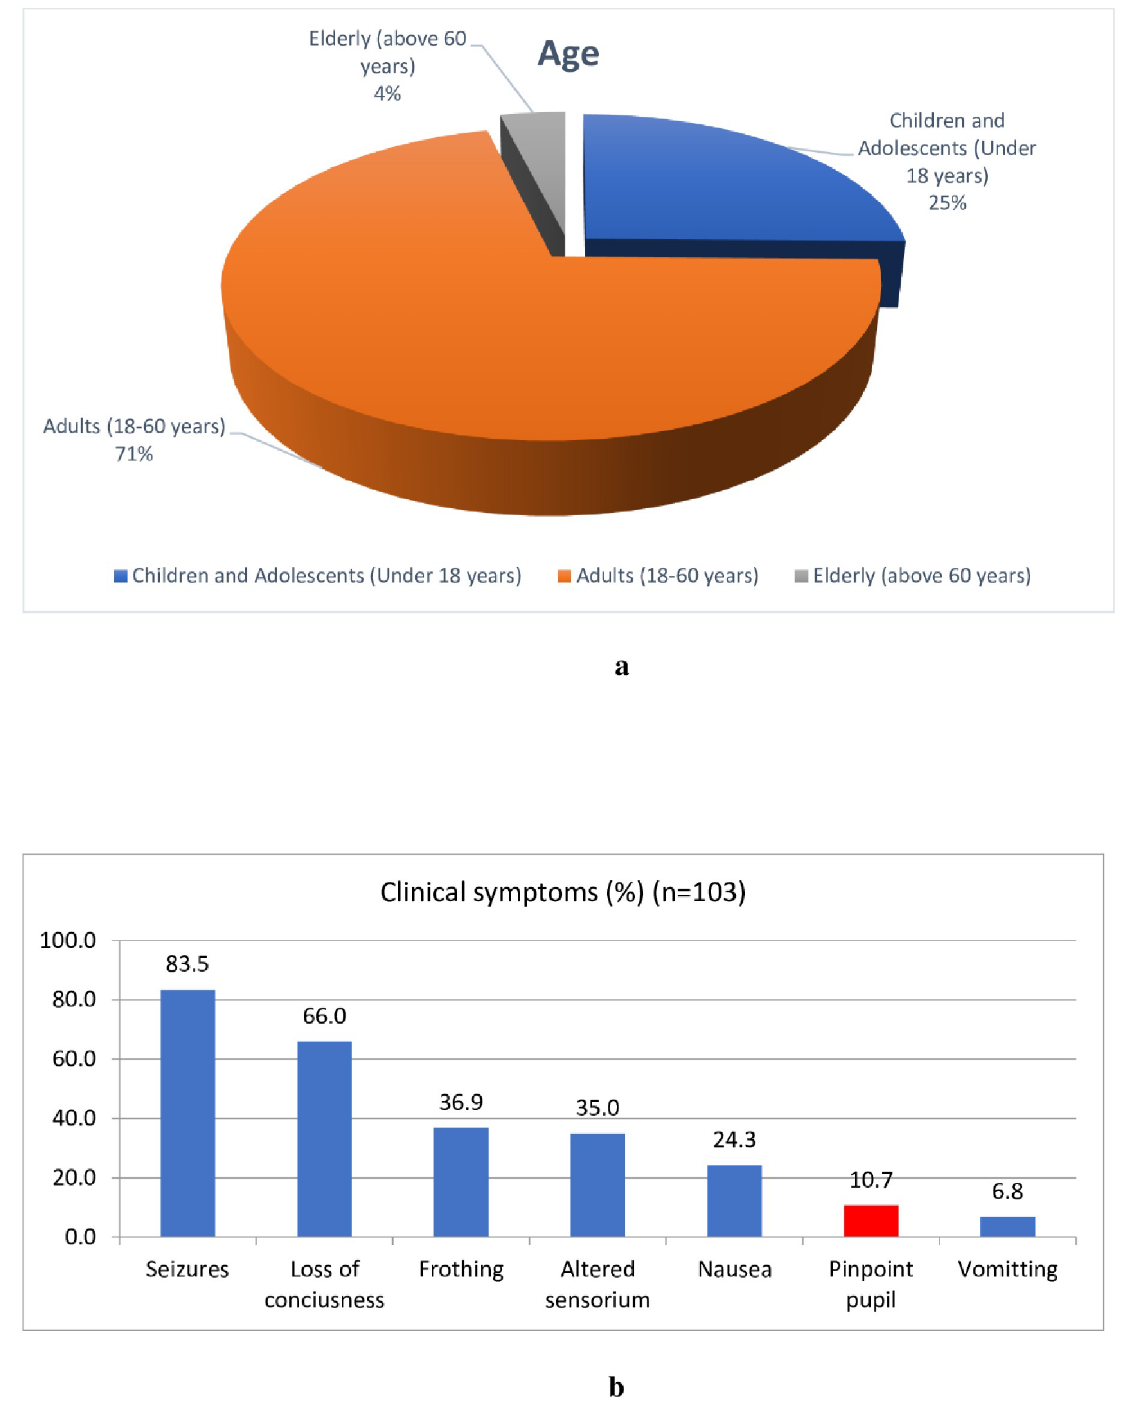
Fig 2. a. Age distribution of all cases (Hospital and community). b. Distribution of Clinical Symptoms in cases admitted in Local Government hospital.